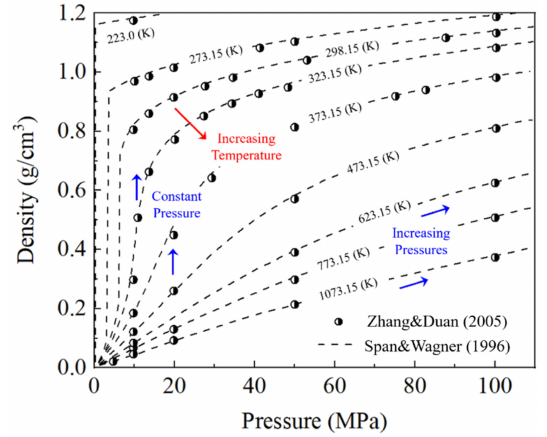
Figure 1. The comparison between simulated densities by different MD potentials. (For an in-depth interpretation of these data, readers are referred to Zhang and Duan’s paper [47]).